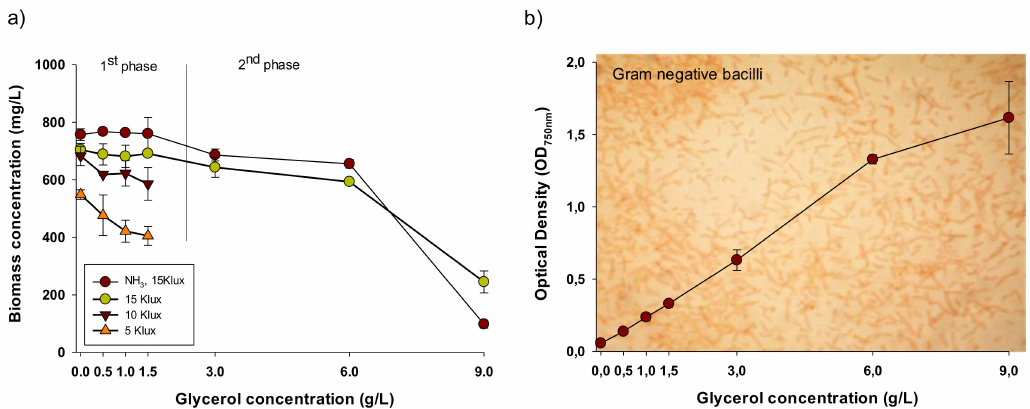
Figure 1. ( a ) Biomass concentration of A. platensis cultivated in semi-continuous mode in modified Zarrouk medium with the supplementation of glycerol (0.5, 1, 1.5, 3, 6 and 9 g / L) under three di ff erent light intensities (5, 10 and 15 Klux) with nitrate as the nitrogen source or with ammonia as nitrogen source (NH 3 of 20 mg-N / L / d at 15 Klux). ( b ) Optical density (OD 750nm ) of the fraction of the bacteria grown on the A. platensis cultures with di ff erent glycerol concentrations (0.5–9 g /